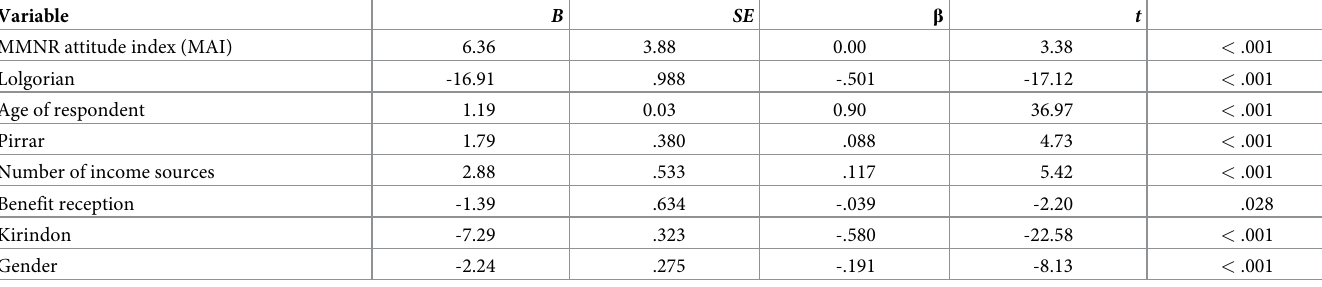
Table 6. Regression results for Maasai Mara National Reserve index (MAI).